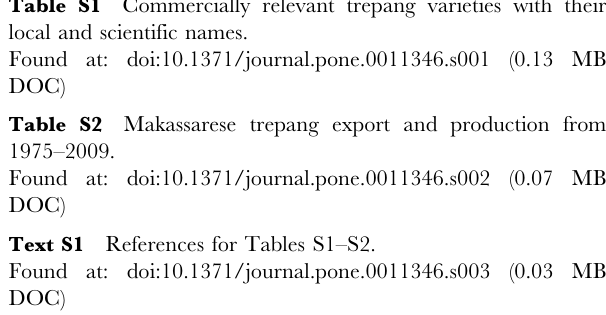
Table S1 Commercially relevant trepang varieties with their local and scientific names.